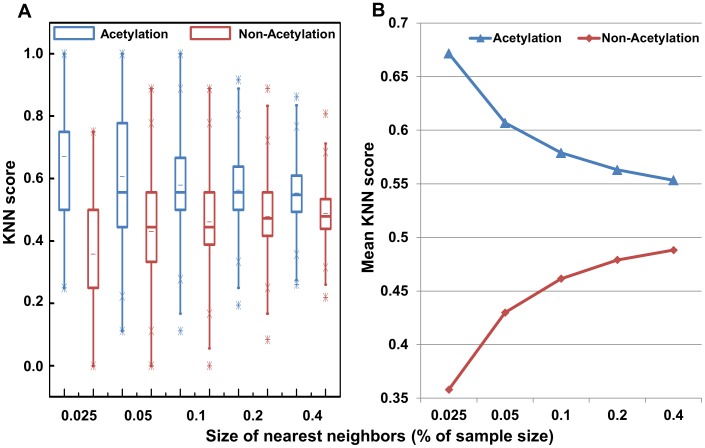
Comparison of KNN scores between acetylation sites and non-acetylation sites.(A) Box plots of KNN scores for acetylation sites and non-acetylation sites. The bottom and top of the box are the 25th and 75th percentiles, respectively. (B) Comparison of mean KNN scores between acetylation sites and non-acetylation sites.